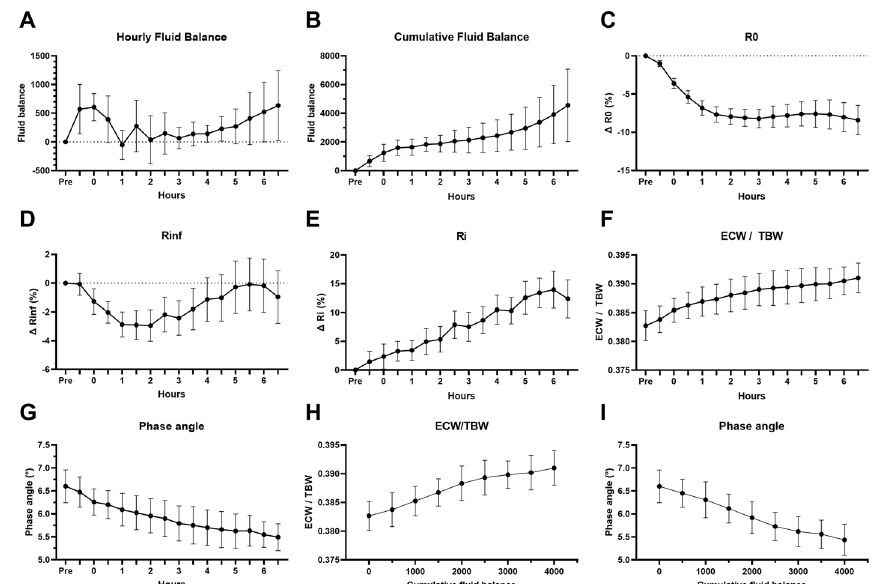
Fig. 2 Trends of fluid balances ( A , B ) and measured bioelectrical impedance analysis variables ( C – G ) over time, and trends of ECW/TBW ( H ) and phase angle ( I ) over cumulative fluid balance of 12 pigs in the E. coli -induced porcine bacteremia model. Data are presented as the means and standard error of the mean. ECW extracellular water, TBW total body water